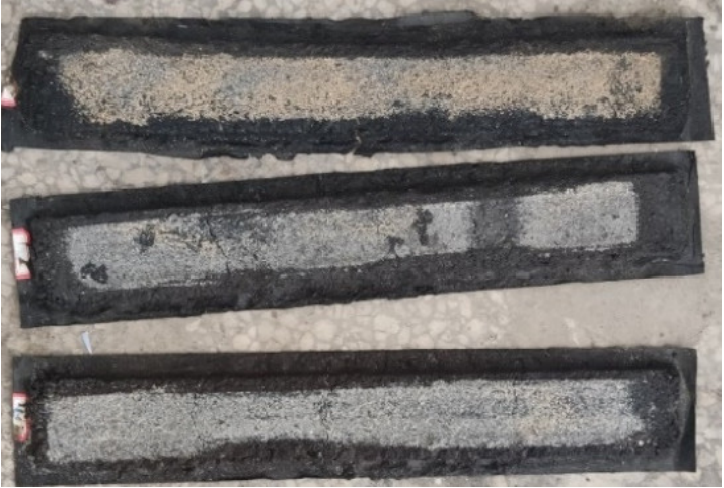
Figure 5. Slurry rutting